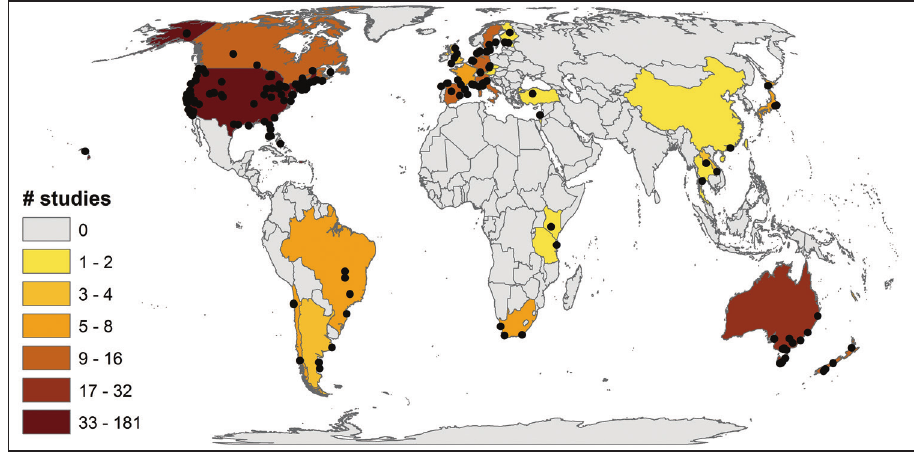
Figure 3. Global distribution of field based aquatic invasion impact experiments ( n = 301; 259 reviewed studies + 42 extra locations from nested or multiple spatially separated experiments within